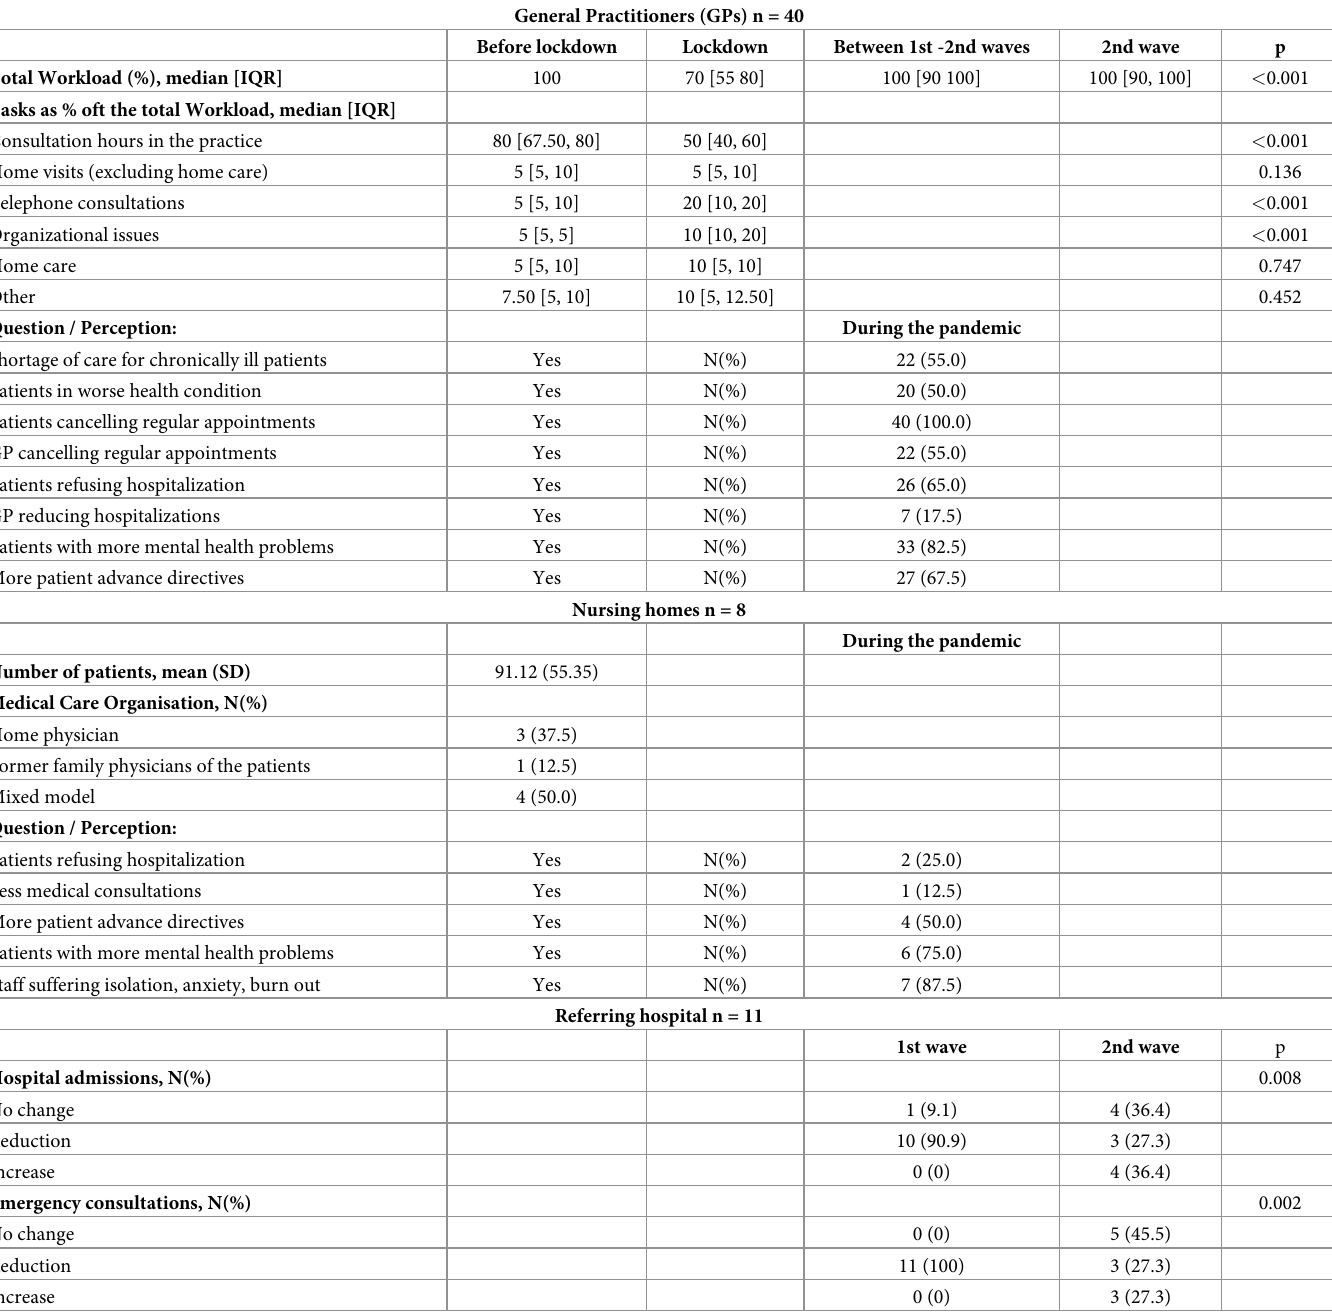
Table 2. Descriptive table of survey results. Lockdown: March 17—April 26. 1st Wave: calendar weeks (10–24); 2nd Wave: calendar weeks